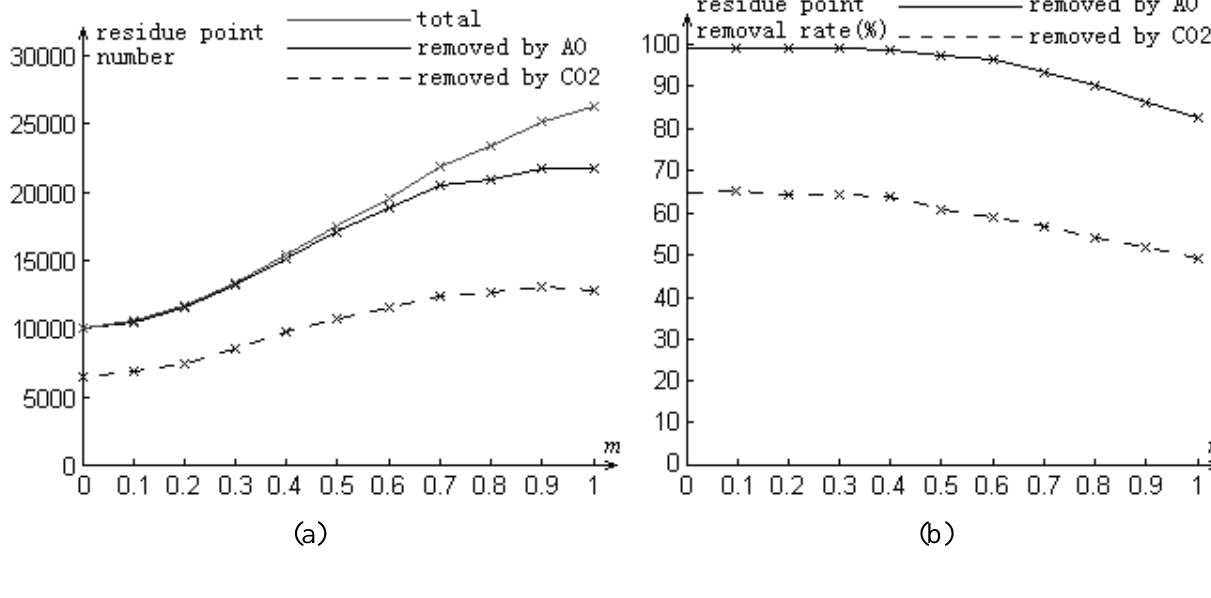
Figure 8. (a) The comparison of the removed residue point numbers obtained by the AO and CO2 methods at different simulated noise level m (in the ML case). The test area is from the frame in Figure 5(a). (b) The corresponding residue point removal